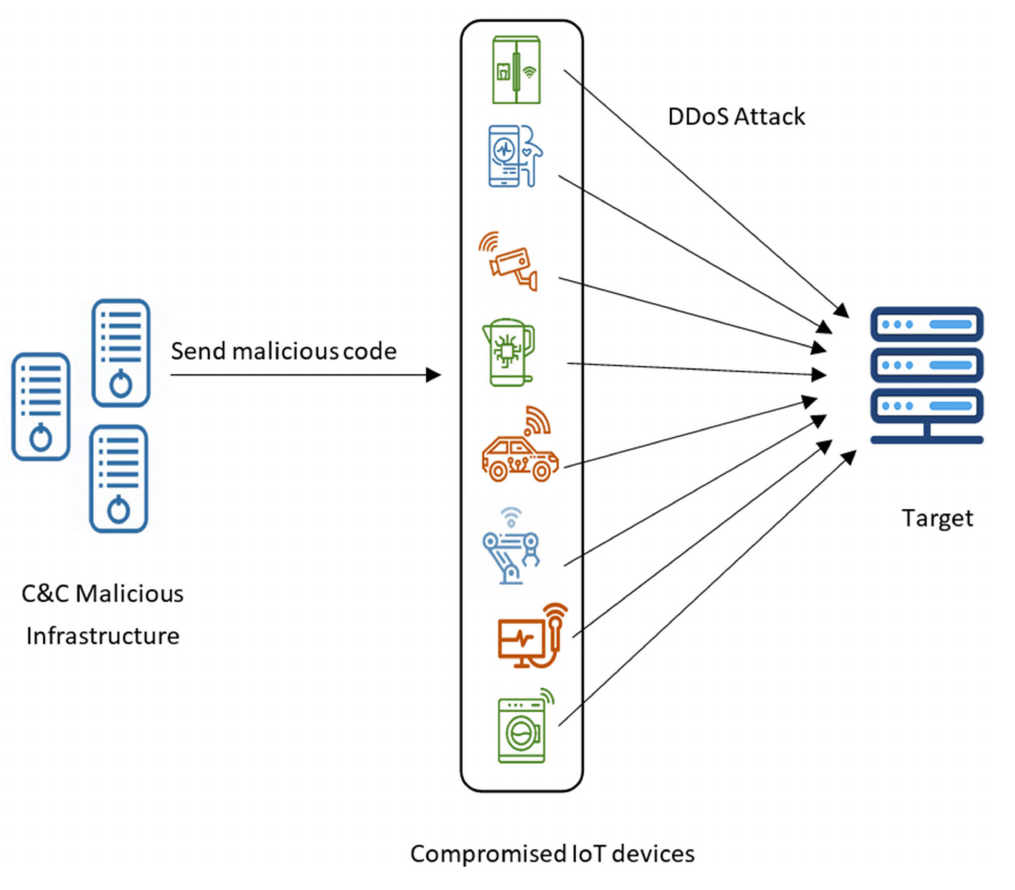
Figure 9. The mechanism of